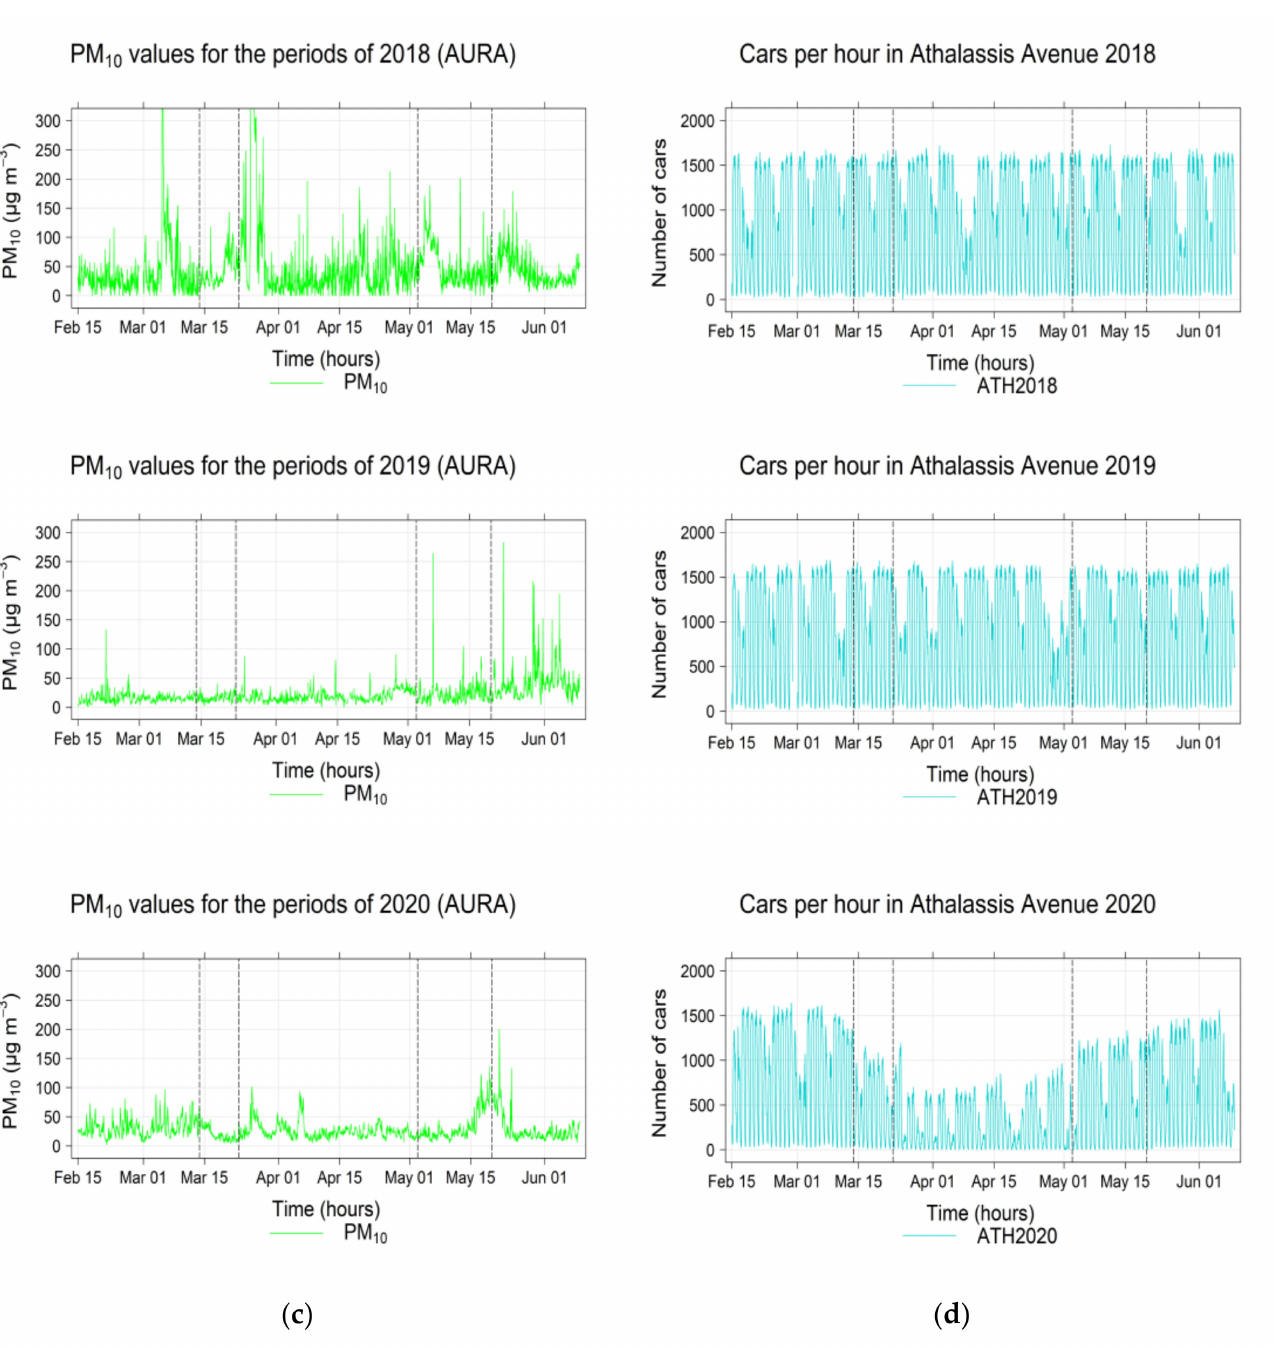
Figure 3. The hourly variation of the concentration values of ( a ) NO 2 , ( b ) CO, ( c ) PM 10 , and ( d ) the number of cars at Athalassis Avenue at the AURA station for 2018, 2019 and 2020. Different time periods are demarcated using a black dashed